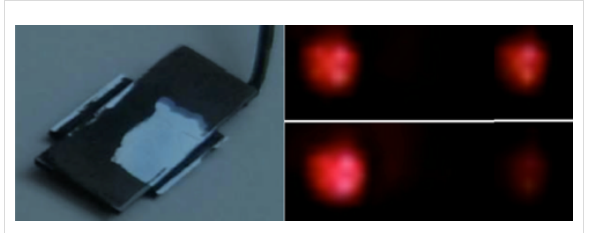
Figure 3: A directional coupler prototype showing power distribution between the output